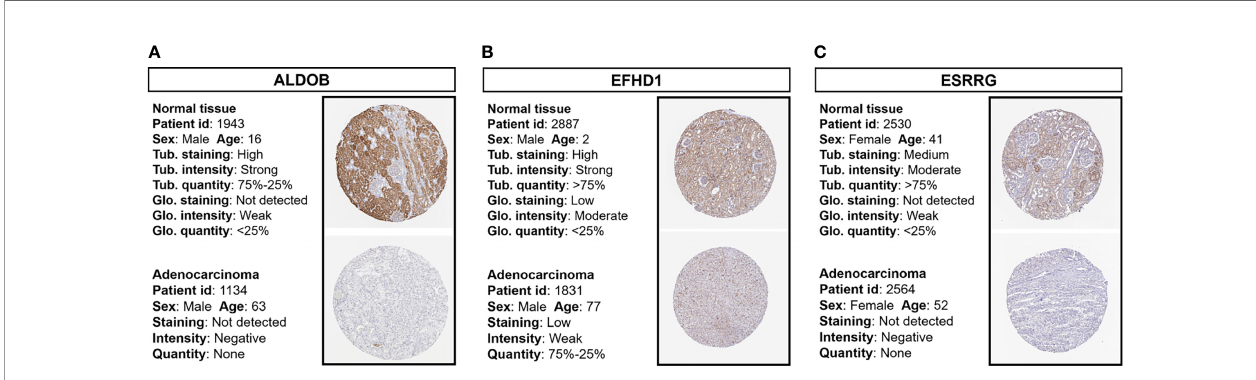
FIGURE 5 | Immunohistochemistry staining of prognostic proteins based on the HPA. Protein expression levels of (A) ALDOB, (B) EFHD1, and (C) ESRRG in tumor tissues and normal tissues. HPA, Human Protein Atlas; Tub., tubules;